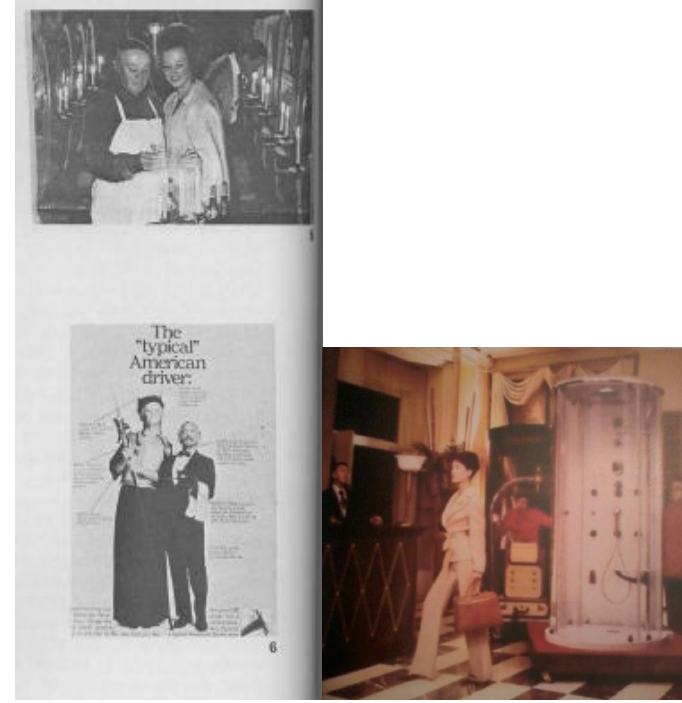
Figure 1. Goffman’s picture and selected picture, when man is shorter than